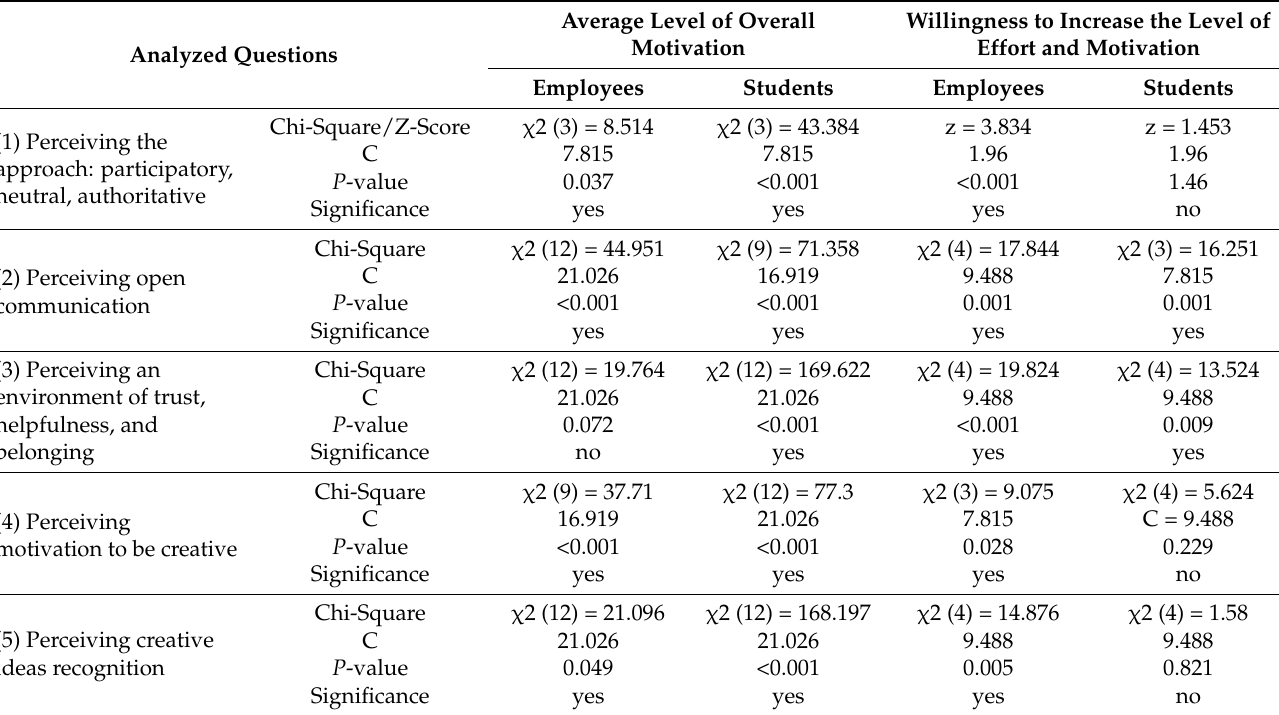
Table 1. Statistical significance of the relationship between selected questions and sustainable motivation—teachers’ and students’